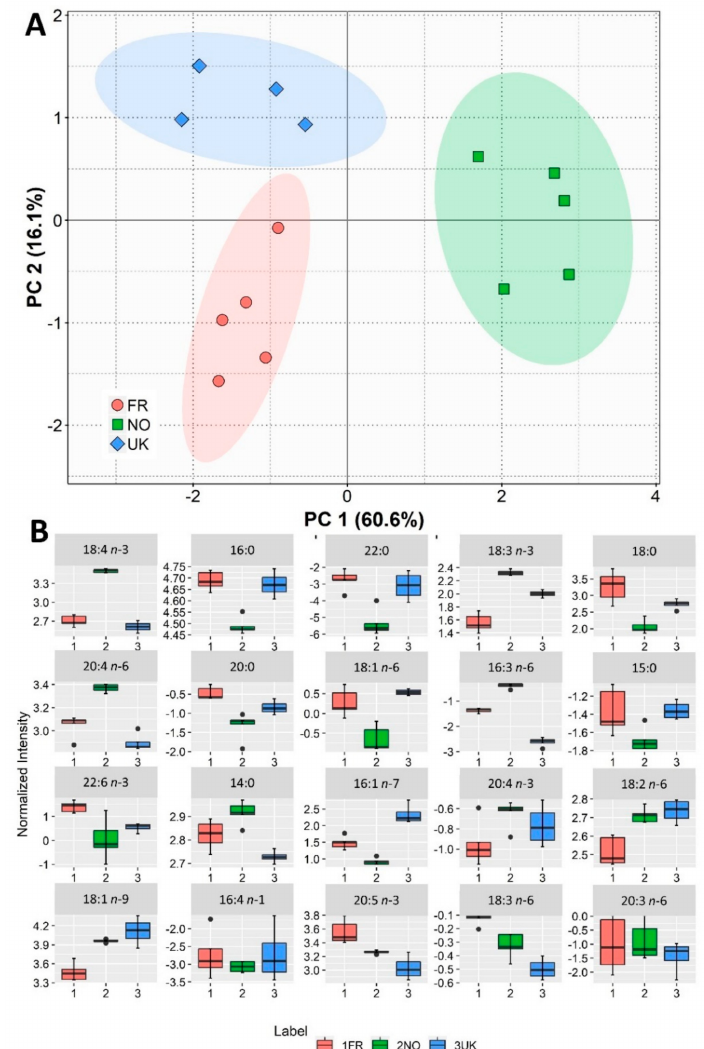
Figure 2. Sample origin discrimination with regard to fatty acid content. ( A ) Principal component analysis (PCA) score plot of the fatty acid profiles (in terms of relative abundance, %) for samples of one of the UK replicates was considered an outlier and was excluded from the analysis). ( B ) Box plots of the fatty acids used to calculate PCA ranging from major to lesser contributors for Principal Component 1 of the PCA (left to right, top to